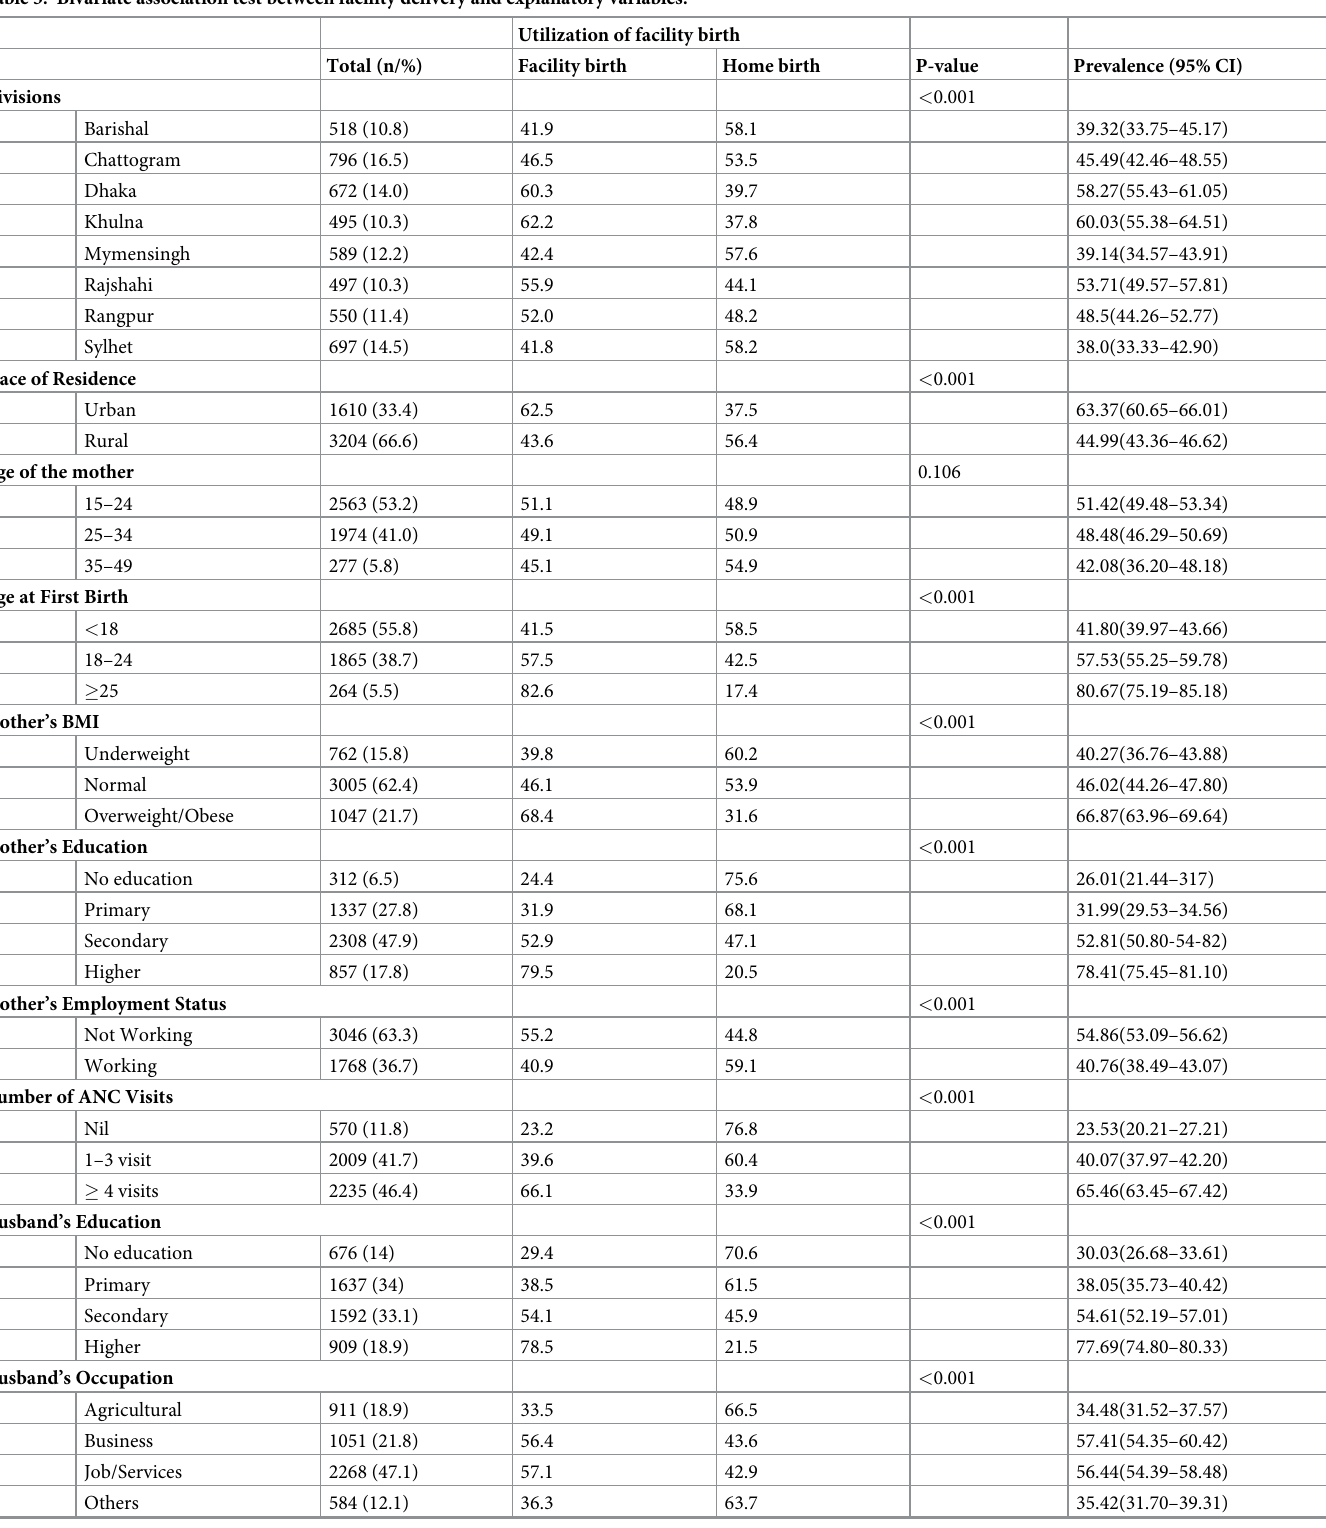
Table 3. Bivariate association test between facility delivery and explanatory